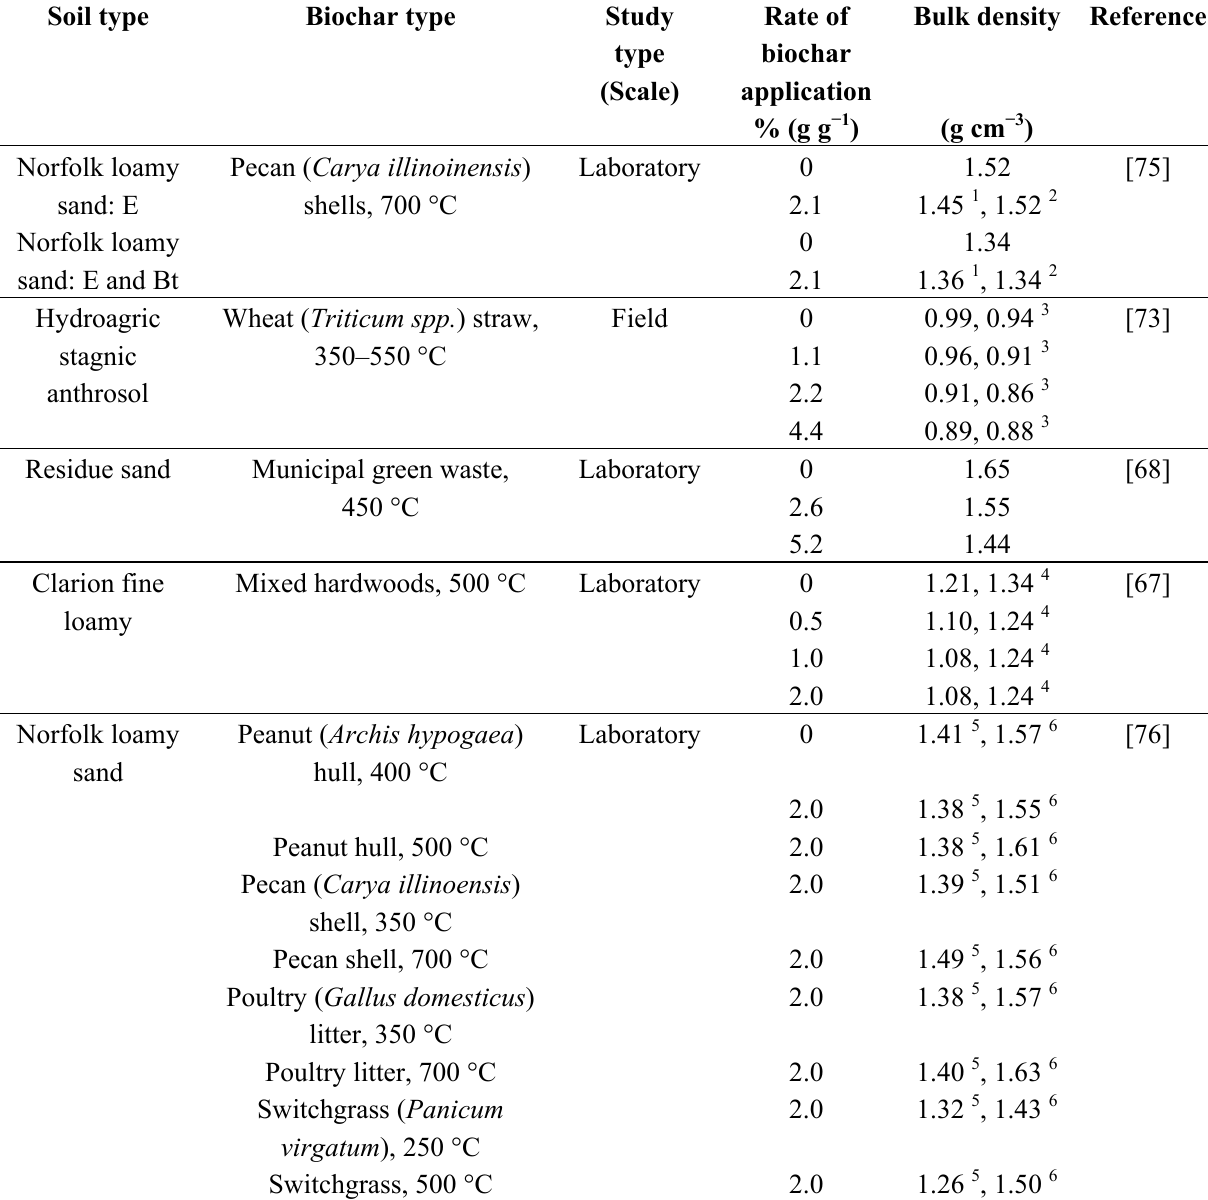
Table 2. Impact of biochar application on soil bulk